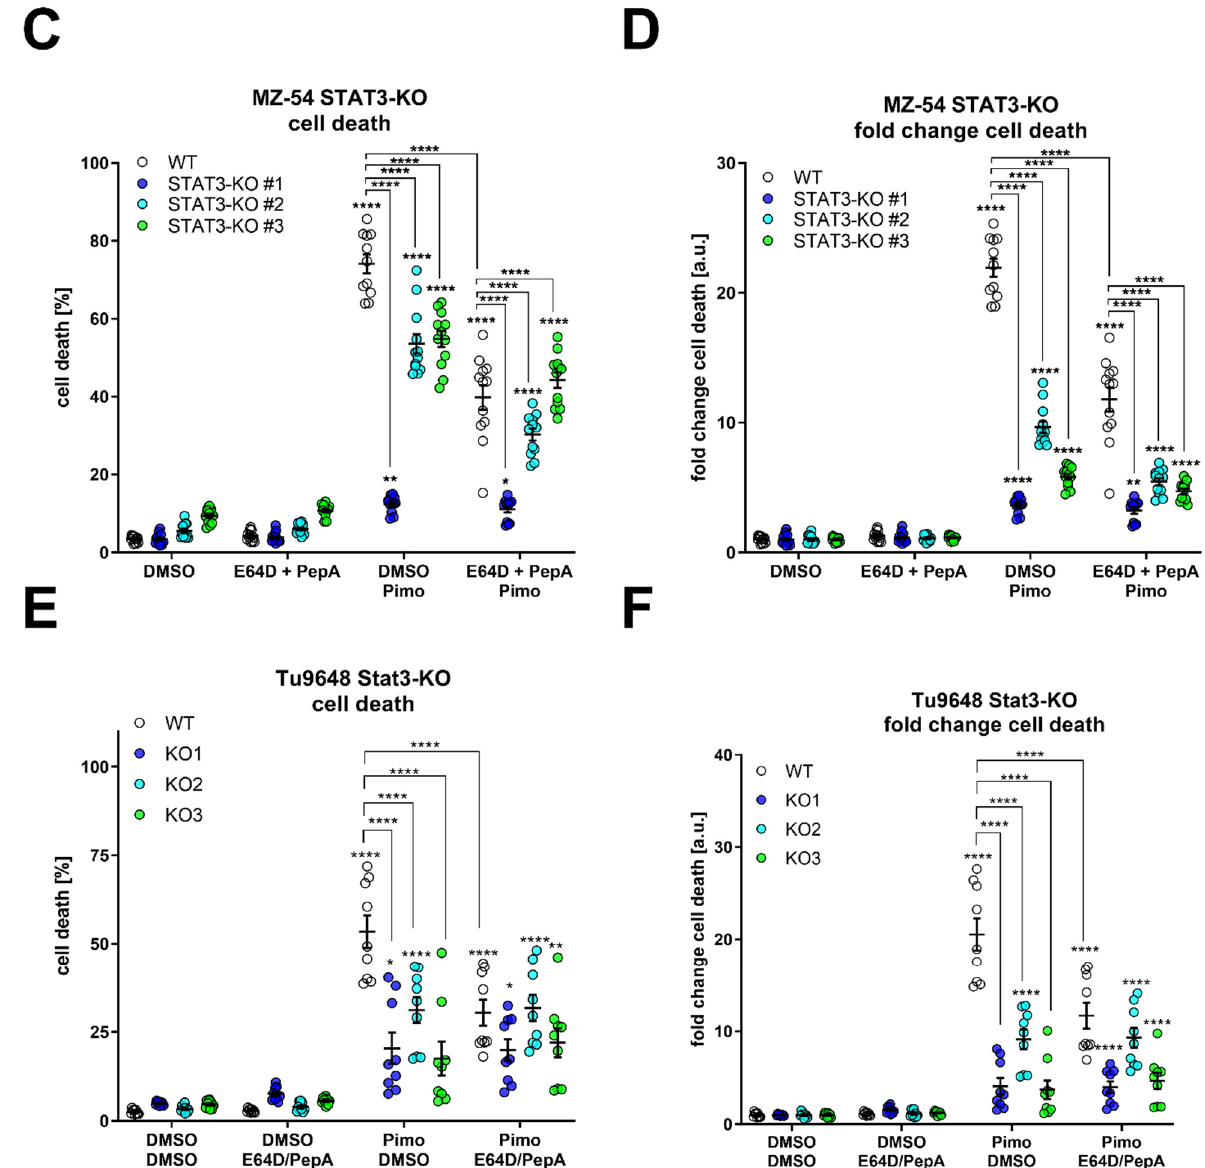
Figure 7. Depletion of STAT3 reduces cytosolic cathepsin activity and inhibition of cathepsins attenuates cell death. ( A , B ) Cytosolic CTSB activity of ( A ) MZ-54 WT and STAT3-KO cells and ( B ) MZ-54 shCtrl and STAT3-KD cells 16 h after treatment with 20 µ M imipramine (IM) and 100 µ M ticlopodine (TIC), 15 µ M Pimozide (Pimo), 40 µ M STF-62247 (STF) or vehicle (DMSO) after cytosolic fractionation (for details see materials and methods section). ( C ) Total cell death was determined by Annexin-V-APC/PI staining and FACS analysis after treatment of MZ-54 WT and STAT3-KO cells after treatment with with 12.5 µ M Pimozide (Pimo) or vehicle (DMSO) with and without additional treatment with the cathepsin-inhibitors E64D (25 µ M) and pepstatin A (PepA, 50 µ M). ( D ) Fold change cell death from the data presented in C. The data are baseline-corrected to each DMSO-treated cell line in order to adjust for baseline cell death-induction after STAT3-KO. ( E ) Total cell death was determined by FACS analysis of Tu9648 WT and Stat3-KO cells after treatment with 7.5 µ M Pimo for 40 h with and without cathepsin-inhibitors. ( F ) Baseline-correction of the data presented in ( E ). The data are presented as point plots of ( A , B ) 2 experiments performed in 5 replicates and ( C – F ) three experiments performed 3–4 replicates. * p < 0.05; ** p < 0.01; *** p < 0.001; **** p > 0.0001; Two-Way ANOVA with Tukey’s multiple comparison test (GraphPad Prism